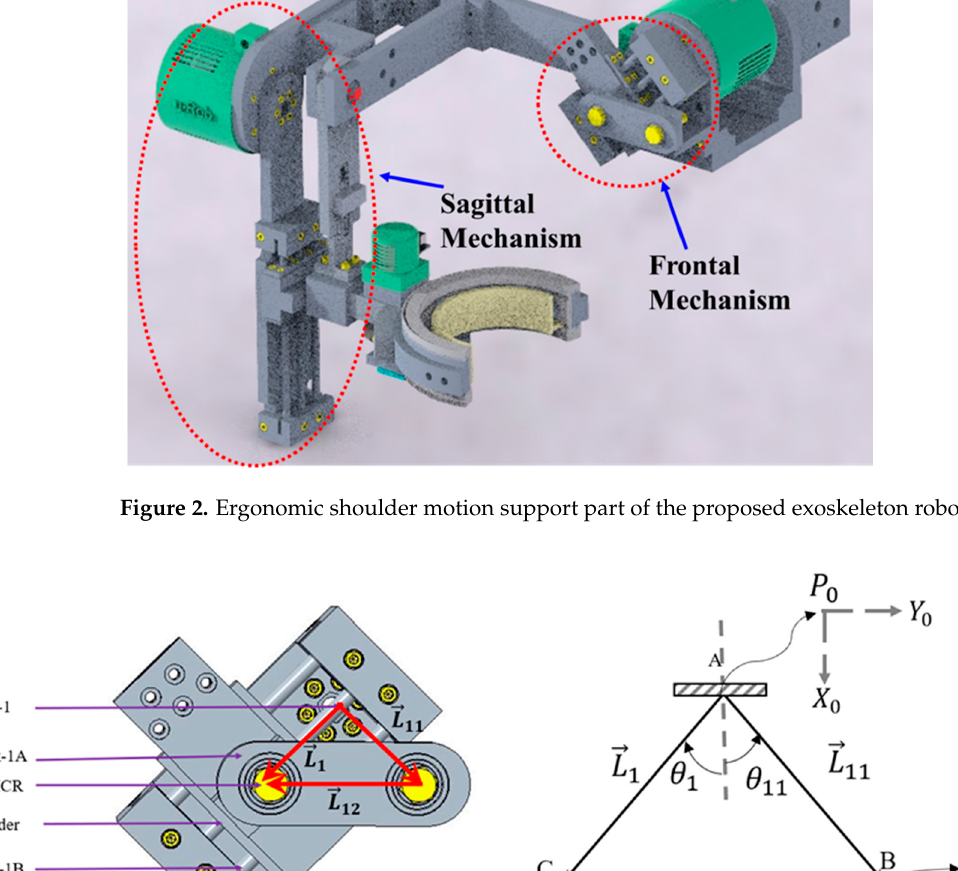
Figure 4. CAD diagram ( left ) and vector formation ( right ) of the sagittal mechanism. Figure 5 shows the exploded view of the frontal mechanism with all the parts used in the fabrication. All the parts, except standard elements (e.g., bearings, bushing, stainless steel shaft), were machined out of aluminum 6061. To provide linear motion, three stand- ard (LM8LUU Linear bushing) sliders (part 3) and three 8 mm stainless steel shafts (part 2) were used, as shown in Figure 5. Note that three sets of sliders were used to prevent rotation of the slider around the axis of the shaft. The shafts were made to fit into the slider bore, whereas the sliders were inserted into the bores of the slider retainers (part 8). To prevent horizontal translation of the slider itself, two preregular plates (part 4) were fas- tened using M4 screws (part 5) at both ends of the slider retainer (part 8). Note that the slider retainer also connects the joint-2 assembly. To hold the shaft, two block parts (part 11) with the appropriate groove and slot were fabricated. These blocks were mounted on the plate (part 9) attached to joint-1. The link-1A (part 1) contains two standard ball bear- ings (6200Z 10 mm × 30 mm × 9 mm double-sealed ball bearings). These bearings were pressed fit and provide bearing support at two M10 screws. The left end of the link-1A (part 1) connected the shoulder joint CR on part 8 and was hinged at the right end.